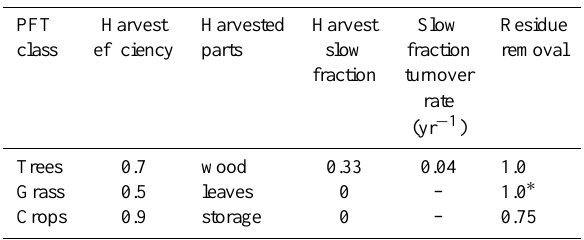
Table 2. LPJ-GUESS PFT harvest parameter values used in this